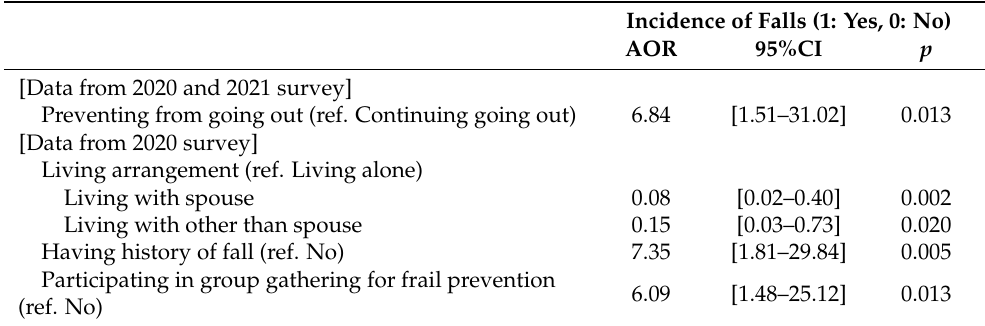
Table 5. Factors of incident of falls among those weekly going out five or more times; multivariate logistic regression analysis (n =